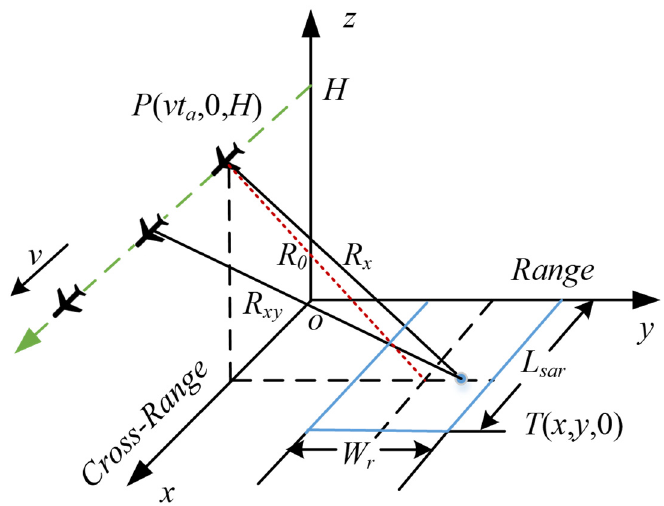
Figure 1. Geometry of the strip-map SAR system.